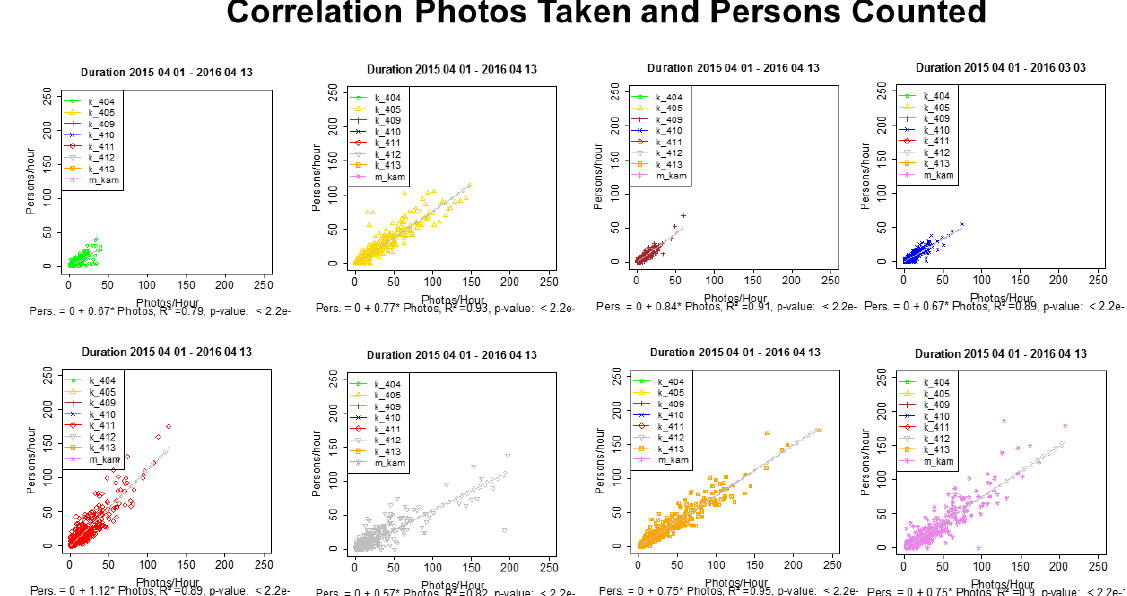
Figure 12. Correlations between pictures taken by cameras and individuals counted in photo assessment process in both monitored forests in Freising, Bavaria, Germany. For color codes and locations of the camera traps, see Figures 1 and 2 and Appendix A, Table A1.